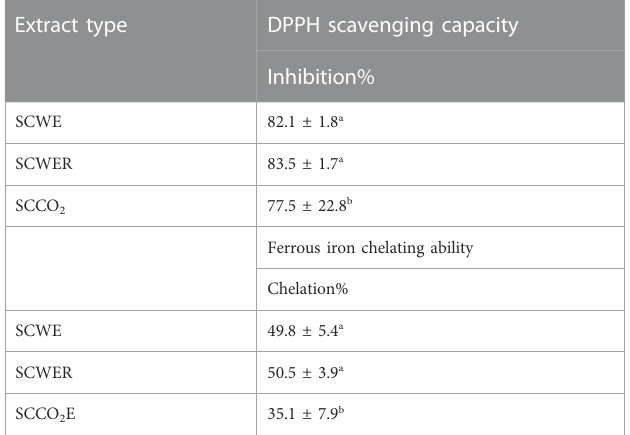
TABLE 3 In vitro antioxidant properties of the extracts; DPPH radical scavenging capacity and ferrous iron chelating ability. The values are for